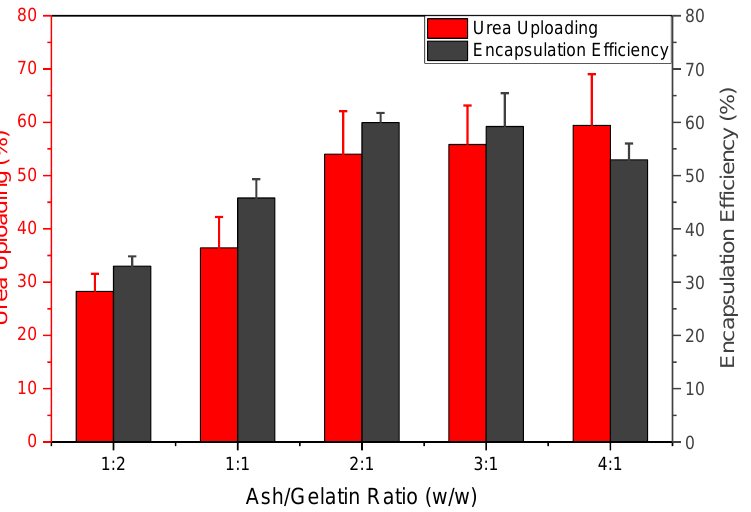
Figure 3. Effect of the increasing ash ratio on urea uploading and encapsulation efficiency in gelatin film. Gelatin film was prepared with a glutaraldehyde content of 2 mL g −1 and a reaction time of 1 h. All values in the figure are represented as mean ± standard deviation.